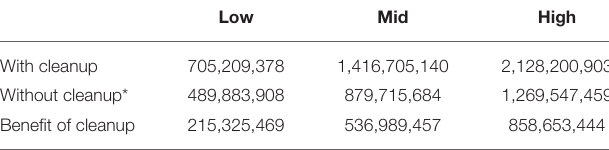
TABLE 6 | Annual value of ecosystem services with and without cleanup (2016$).